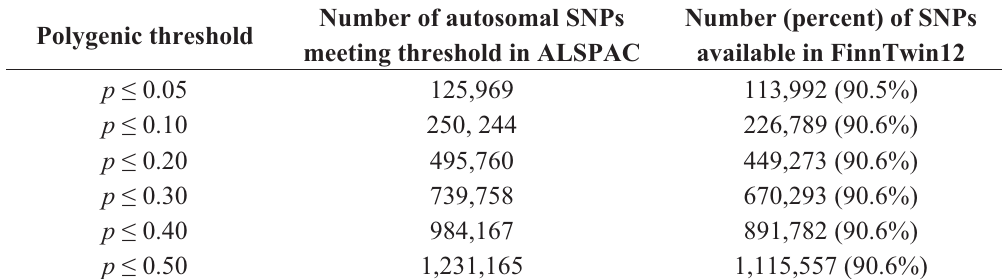
Table 1. Autosomal single nucleotide polymorphisms (SNPs) contributing to each polygenic threshold in Avon Longitudinal Study of Parents and Children (ALSPAC) sample, and availability in